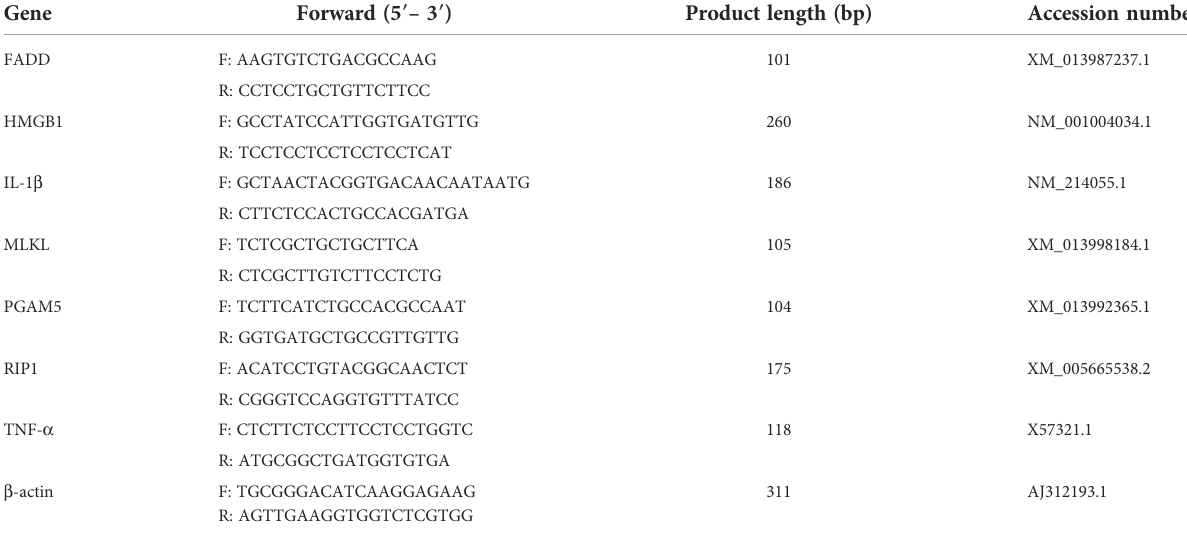
TABLE 1 Primer sequence used for real-time PCR.